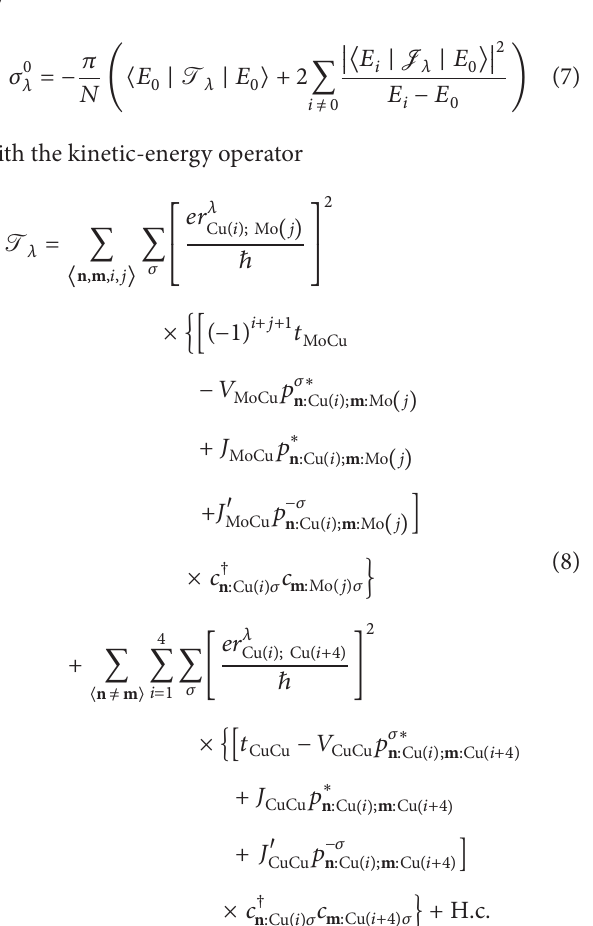
Figure 4: (a) An energy dispersion relation and (b) polarized optical conductivity spectra of the PM state. The Fermi energy 𝜀 by a dotted horizontal line. The optical conductivity spectra perpendicular and parallel to the 𝑐 direction are given by 𝜎 ⊥ (𝜔) = 𝜎 𝑎 (𝜔) + 𝜎 𝑏 (𝜔) and 𝜎 ‖ (𝜔) = 𝜎 𝑐 (𝜔) , respectively. An arrow indicates a photon energy of pumping light, which is discussed in Section 4.